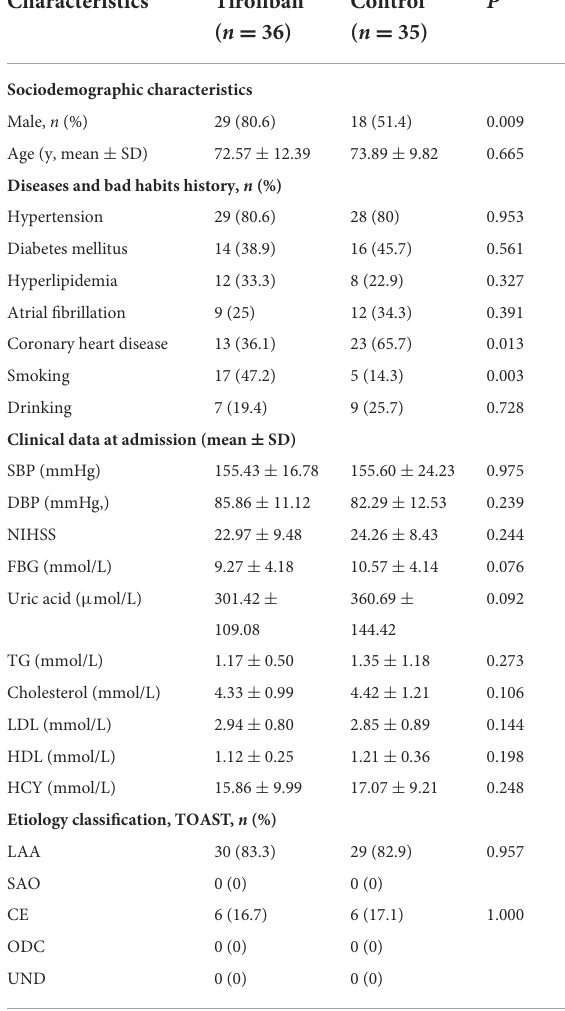
TABLE 1 Characteristics of the patients at